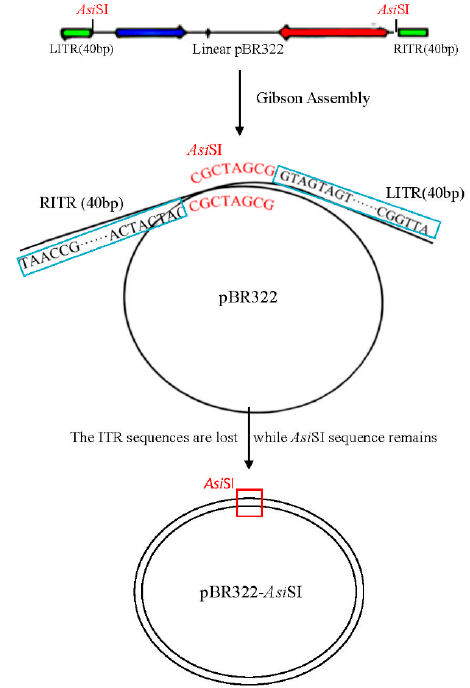
Figure 9. The possible mechanism of the emergence of false positive clones. Linear pBR322 fragment obtained by PCR contained Asi SI sites and 40 bp of left ITR (LITR) and right ITR (RITR) sequences. During Gibson Assembly, the homologous region ( Asi SI sequence) remained while both 40 bp of LITR and RITR were lost. The false positive clones PBR322-AsiSI were produced with Asi SI sequence inserted at the linearized site of PBR322.